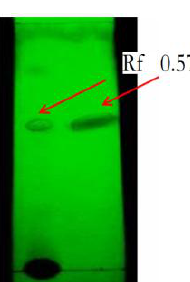
Figure 1. Thin layer chromatograms of andrographolide in sambiloto infusion (left) and andrographolide standard (right).